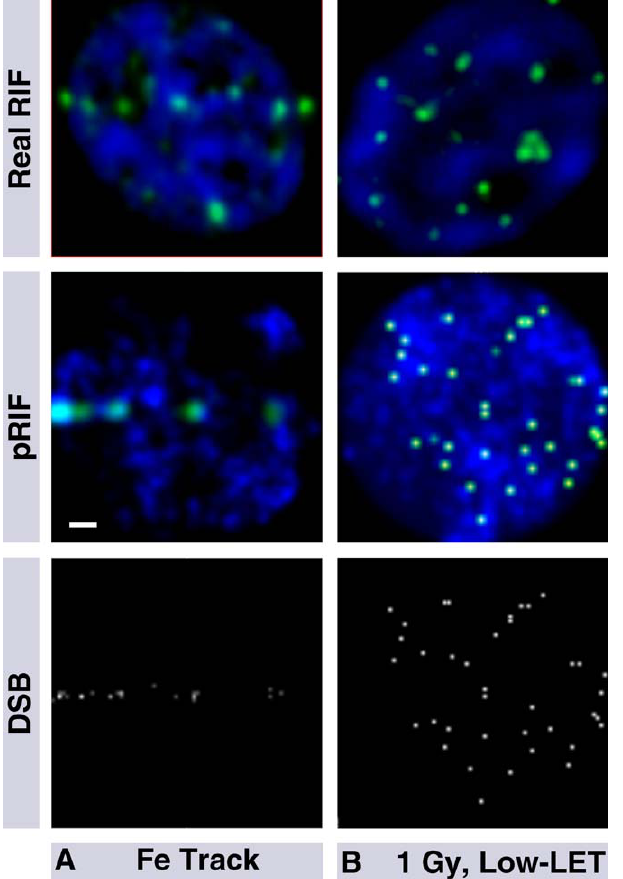
Table 1. RIF Frequencies in Experimental Data and Simulations